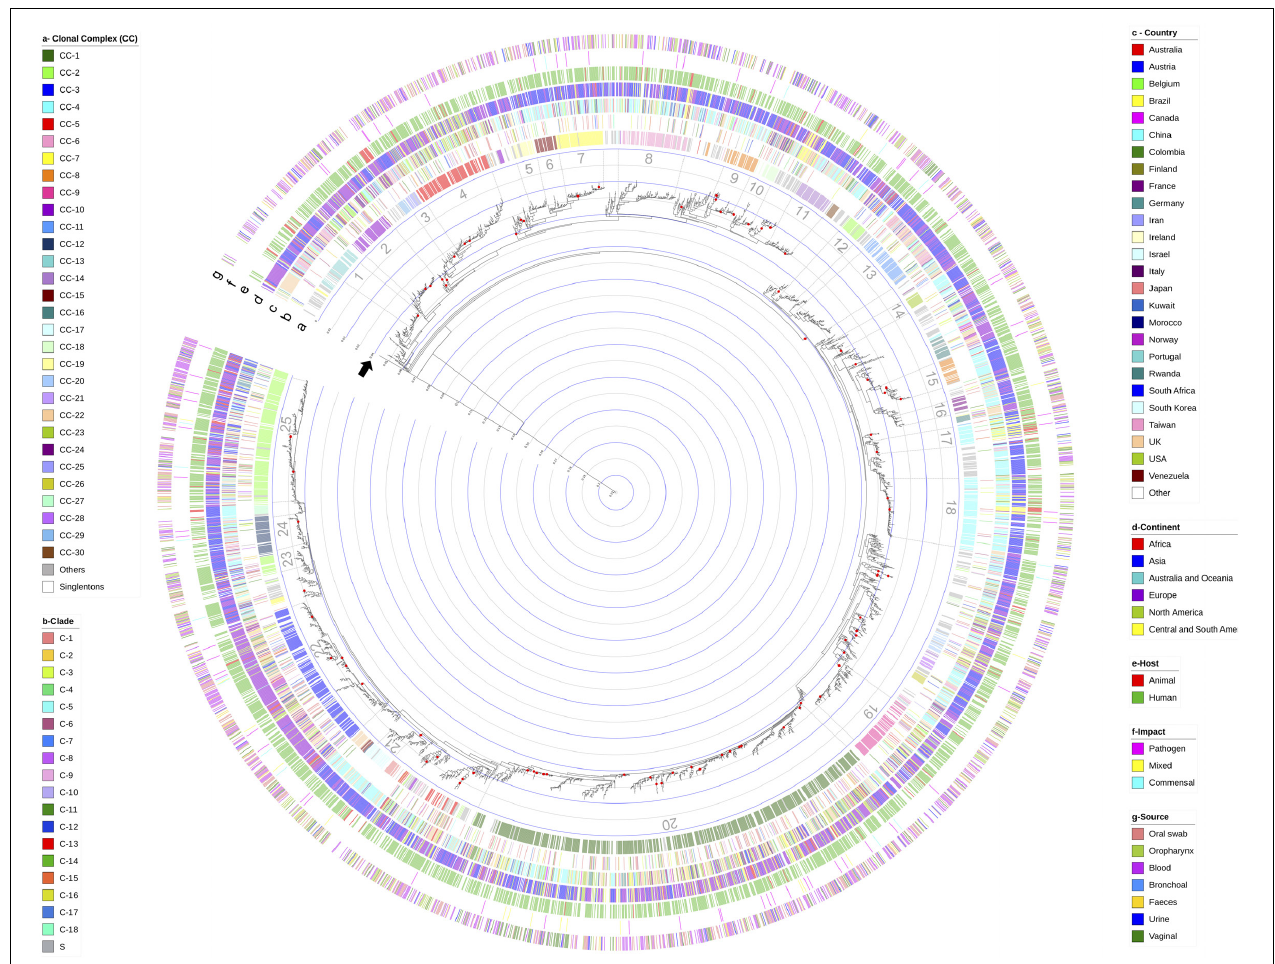
FIGURE 4 | Phylogenetic reconstruction based on the alignment of the concatenated sequences for the total number of reported DSTs ( n = 3,493). The FastTree method was implemented, considering the Jukes-Cantor evolution model (identified as the best-balanced support by the CAT approximation). The red points on the nodes represent well-supported BTs ( ≥ 99.9). The concentric circles inside the tree indicate the p-distance. The black arrow indicates a p-distance of 0.04 and represents the threshold reported for the definition of minor clades (McManus and Coleman, 2014). Each external circle represents the comparison using the different evaluated variables, being (a) clonal complex (CC); (b) classically defined clades; (c) country where the isolations were established; (d) grouping by continent from where the isolates were obtained, and the host type: humans and non-human animals; (f) the potential impact on the hosts: Non-Healthy, commensals or mixed; and (g) sample source from where the isolates were obtained. Bars in the external circles indicate the existence of data for each isolate. Color was assigned according to the categories described by the conventions described on the sides of the